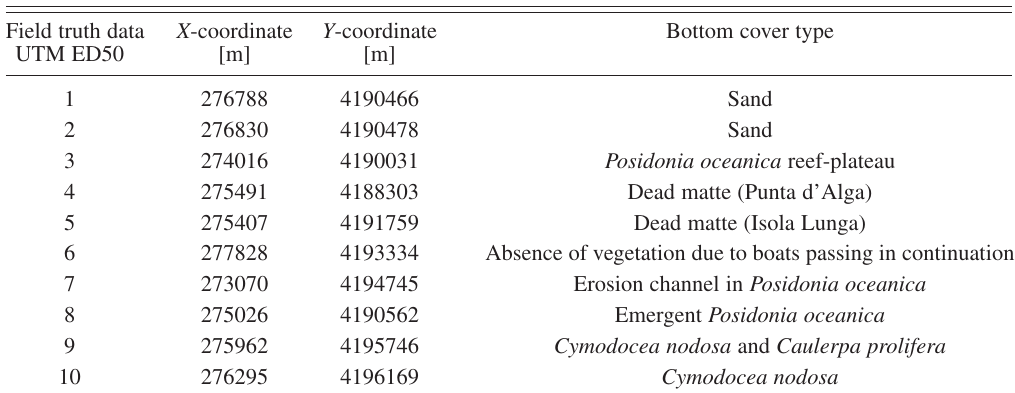
Table II. Field truth data. Field truth data